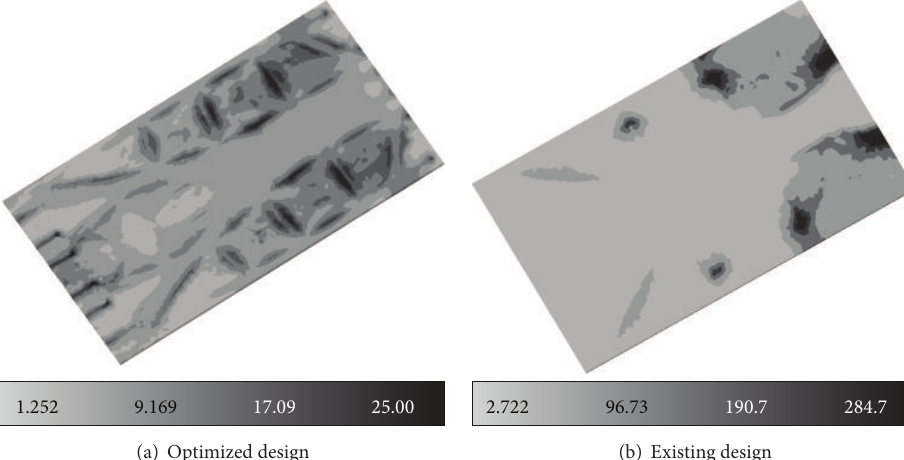
Figure 11: Stress distribution in the bottom plate